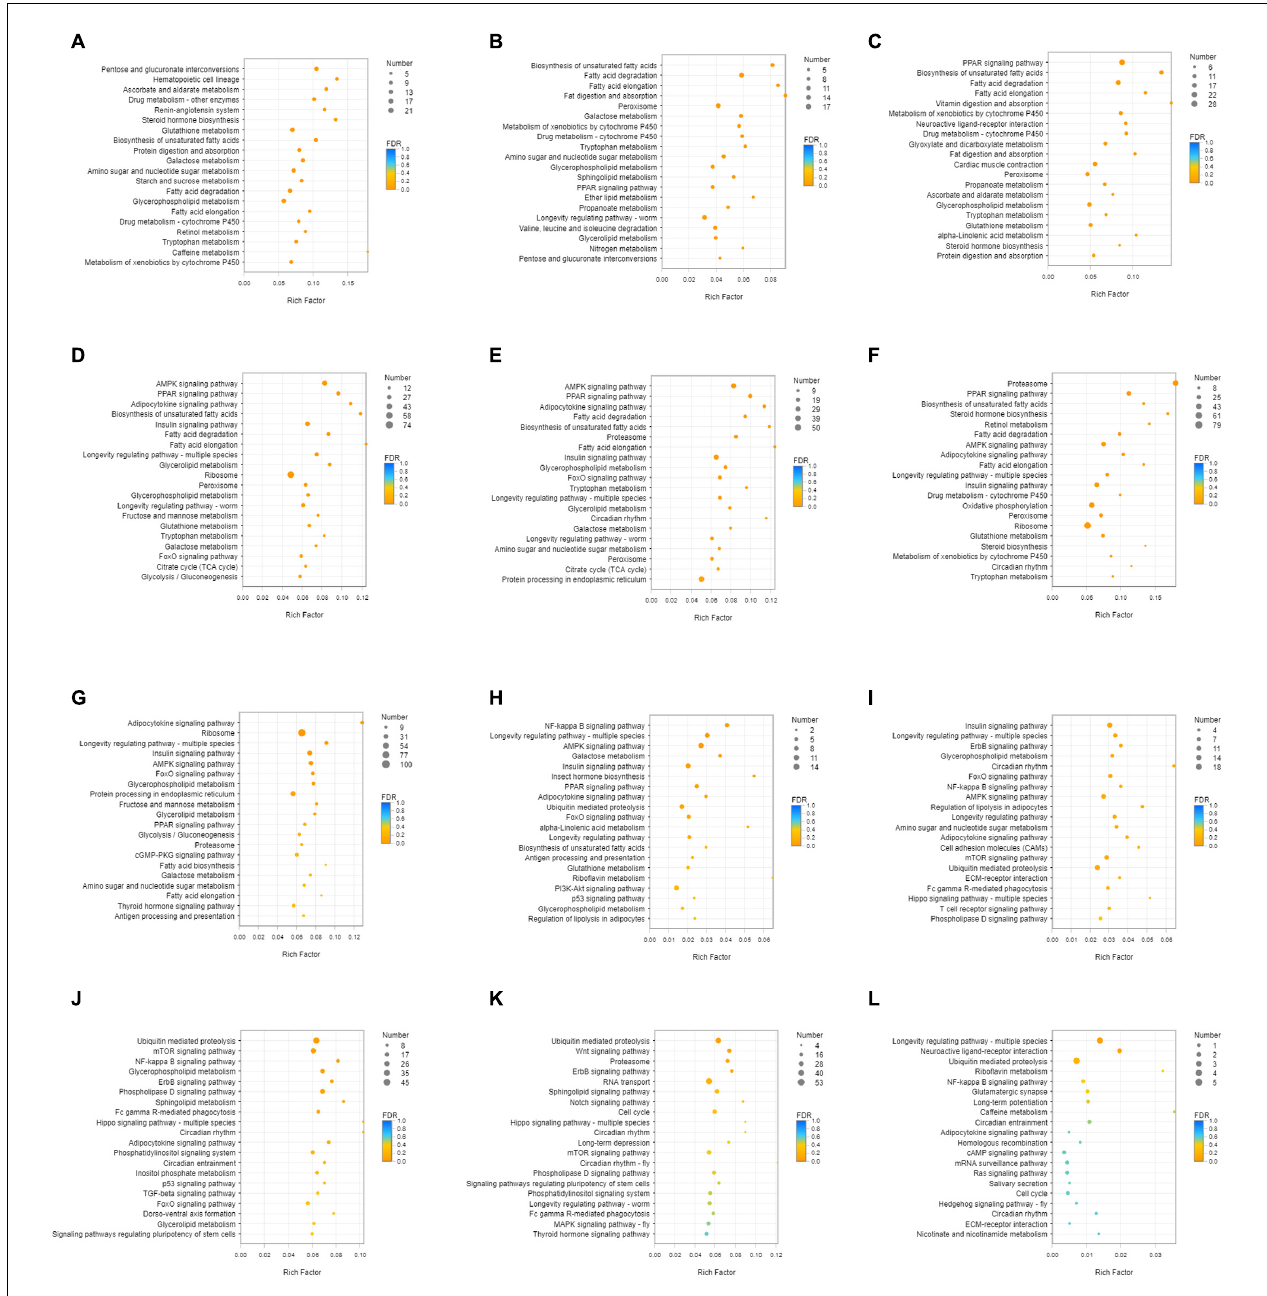
FIGURE 2 | KEGG enrichment analysis of up-regulated DEGs. (A) DEGs of SI_1 (B) DEGs of SI_2 (C) DEGs of SI_3 (D) DEGs of SI_4 (E) DEGs of SI_5 (F) DEGs of SI_6 (G) DEGs of SI_7 (H) DEGs of SI_8 (I) DEGs of SI_9 (J) DEGs of SI_10 (K) DEGs of SI_11 (L) DEGs of SI_12. The picture shows the top 20 differential metabolic pathways with the smallest P